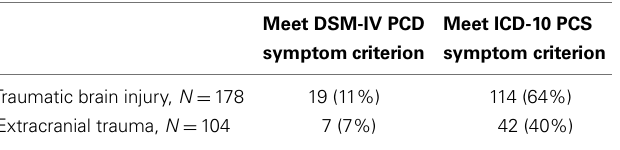
Table 3 | Comparison of post-concussion symptoms followingTBI and extracranial injury Boake et al.